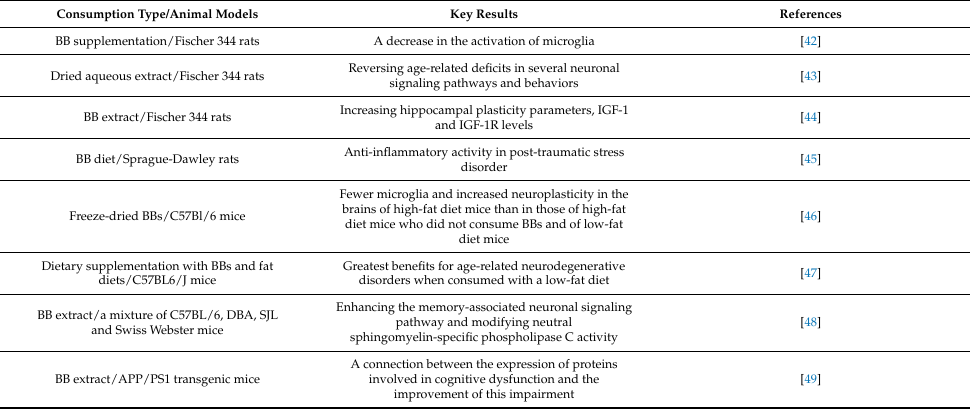
Table 2. In vivo studies of BBs on brain health